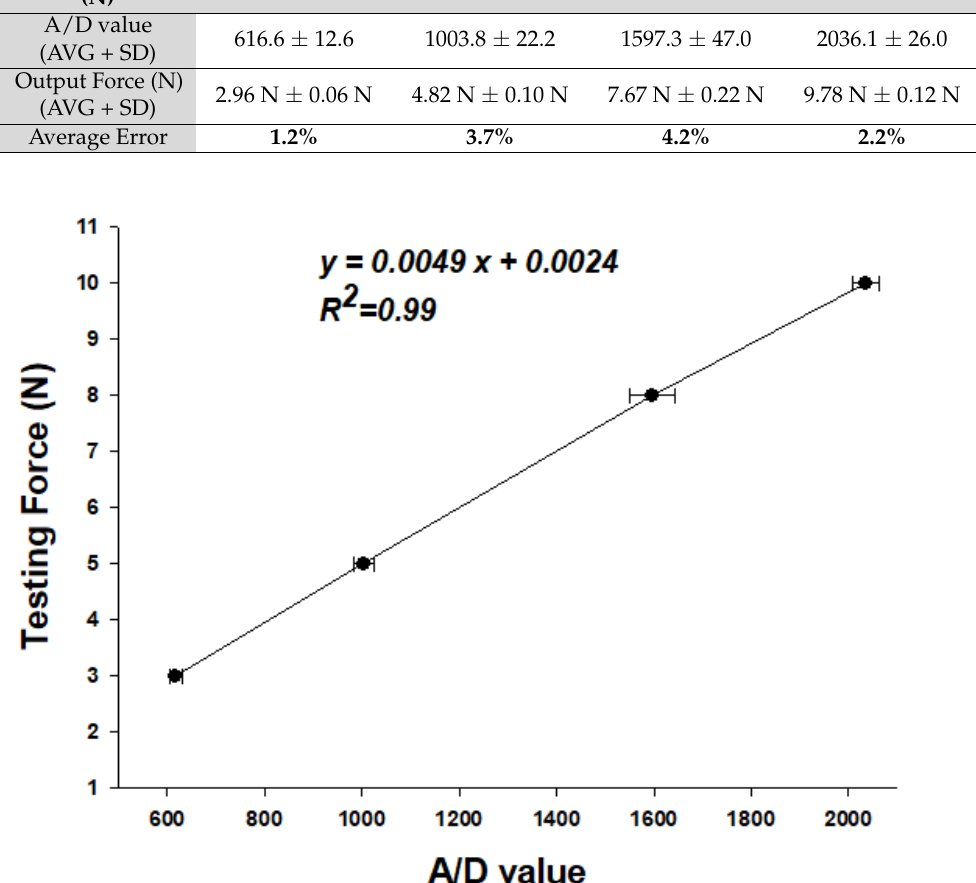
Figure 7. Linear regression results between the A/D values and testing force (N). Table 1. Errors of output force calculated by the regression curve equation .